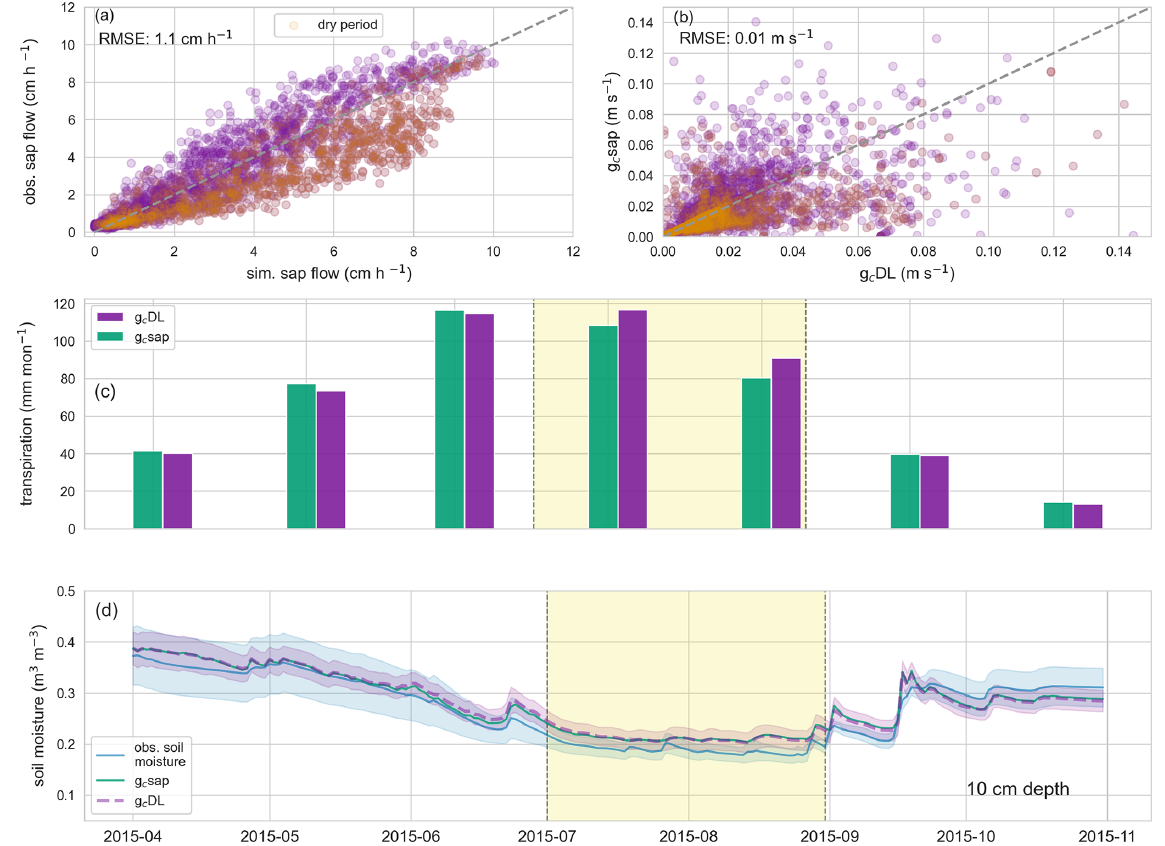
Figure 4. (a) Hourly observed catchment-averaged sap flow and simulated sap flow in the growing season 2015; (b) hourly canopy con- ductances based on the hourly observed sap flow ( g c sap) and simulated sap flow ( g c DL); orange points in (a) and (b) are simulations or observations within the dry period of July and August 2015; (c) monthly transpiration sums estimated by g c sap (green) and g c DL (purple); (d) observed (blue) and simulated soil moisture ( g c sap: green; g c DL: purple) in 20cm. Highlighted in yellow is a dry period from July to August in the growing season